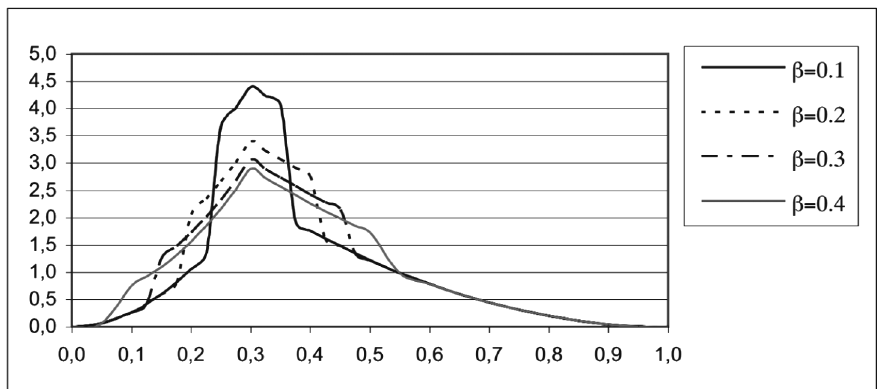
Figure 4 – Probability density function of some MTSP distributions ( κ =0.3, θ =0.3, α =0.2, β vari-